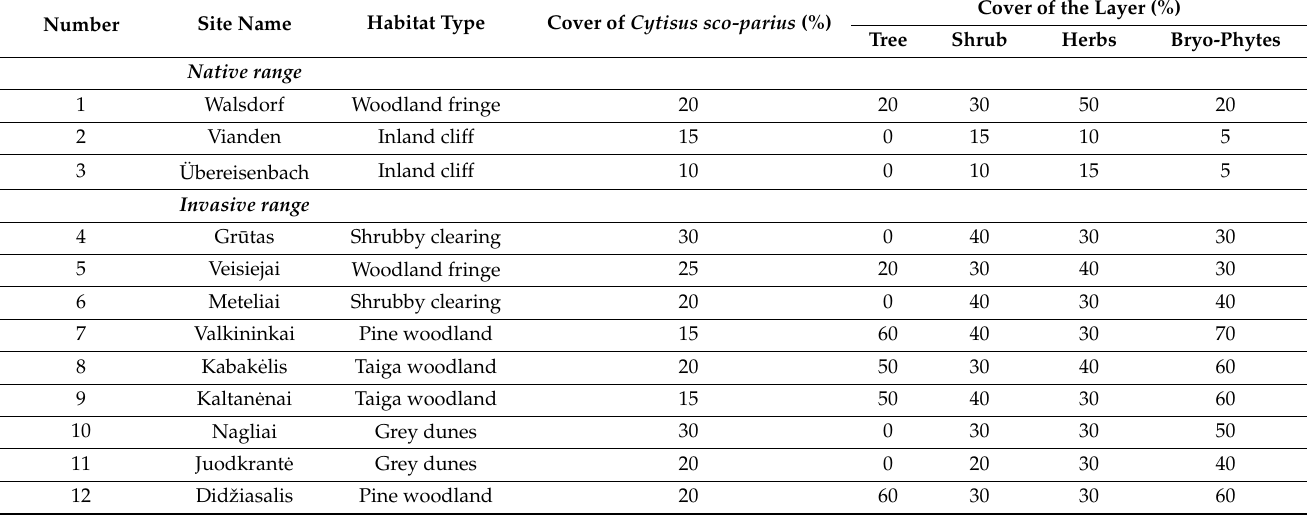
Table A1. The studied populations of Cytisus scoparius, their occupied habitats and the vegetation characteristics of the